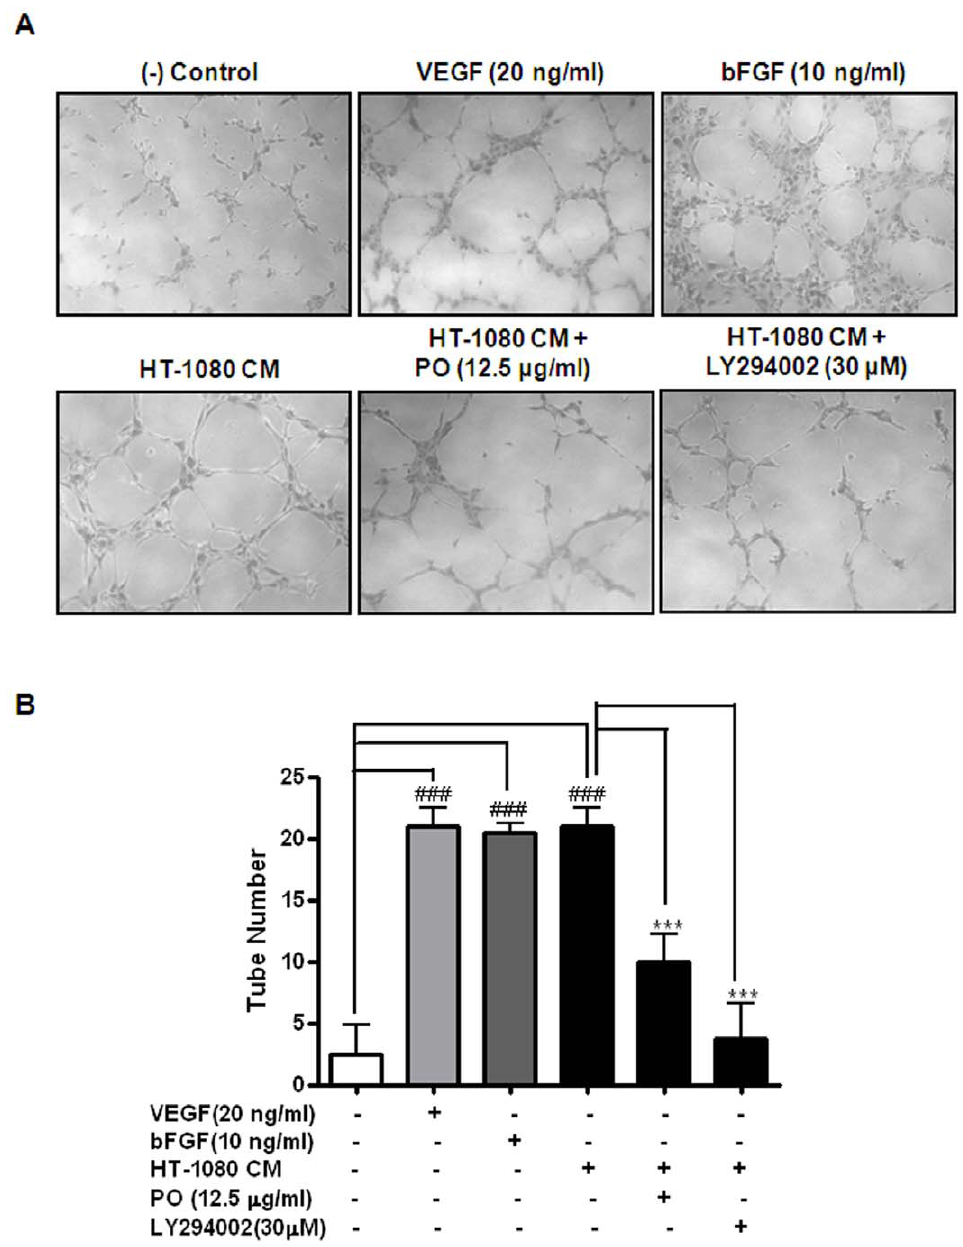
Figure 6. PO inhibits the tube formation of HUVECs induced by culture supernatants of HT-1080 cells. Tube formation assay was performed using growth factor reduced Matrigel. (A) Cells were fixed with Diff-Quick solution and photographed randomly under an Axiovert S 100 light microscope at 6 100 magnification. (B) Tube networks were quantified using NIH Scion image program. All data were expressed as mean 6 S.D. The statistically significant differences between control and PO treated groups were calculated by the Student’s t- test. ### , p , 0.001 versus untreated control in M199 medium. *** , p , 0.001 versus culture supernatant from HT-1080.